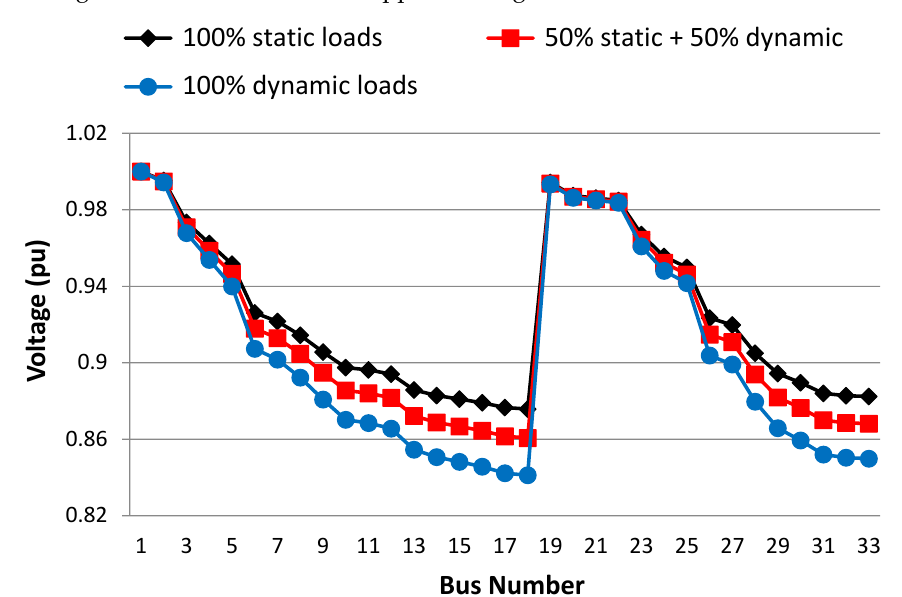
Figure 6. Effect of load type on voltage profile at 150% loading. The same occurs at 200% loading, where the minimum voltage in static load drops to 0.841 pu, and the losses increase to 559.30 kW and 369.07 kVAr less than other cases, as seen in Table 3. In both other cases—50% static and 50% dynamic and 100% dynamic—the voltage and power losses are worse. Figure 7 shows the voltage profile for the 200% loading condition. Table 3. Comparison between static and dynamic loads at 200% loading, i.e., a total load of (7161 + j3490) kVA.